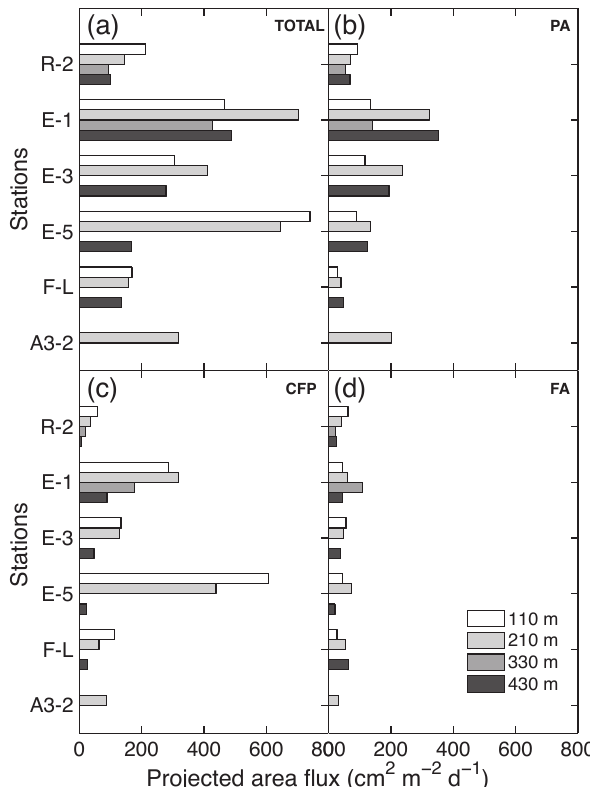
Figure 6. Projected area of particles estimated from image analy- sis at each site and depth and expressed as fluxes (cm 2 m − 2 d − 1 ). (a) All particles (TOTAL), (b) phytodetrital aggregates (PA), (c) cylindrical fecal pellets (CFP) and (d) fecal aggregates (FA). The figure suggests a sinking flux dominated by cylindrical fecal pellets at the surface, except at R-2, where phytodetrital aggregates repre- sented the most important fraction. The attenuation of the cylindri- cal fecal pellet flux with depth observable at all stations was com- bined with an increase in the flux of phytodetrital and fecal aggre- gates at almost all stations. At 430m, phytodetrital aggregates were then the most dominant